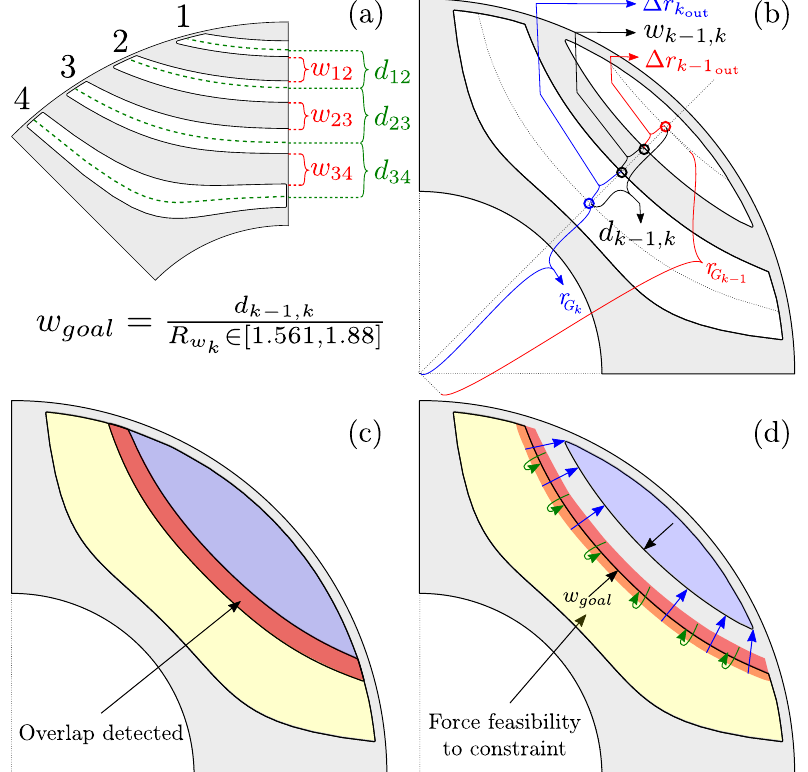
Figure 6. Empirical flux carrier width range ( a ); feasibility check parameters ( b ); infeasible geometry ( c ) and forced feasibility ( d